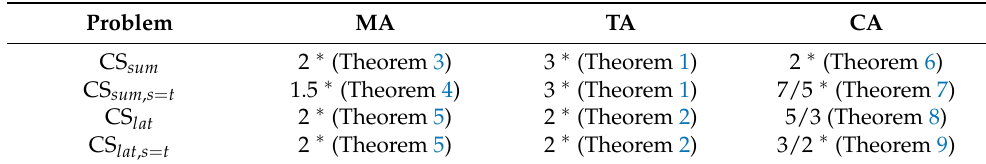
Table 2. Overview of our results for ride-sharing problems with c =